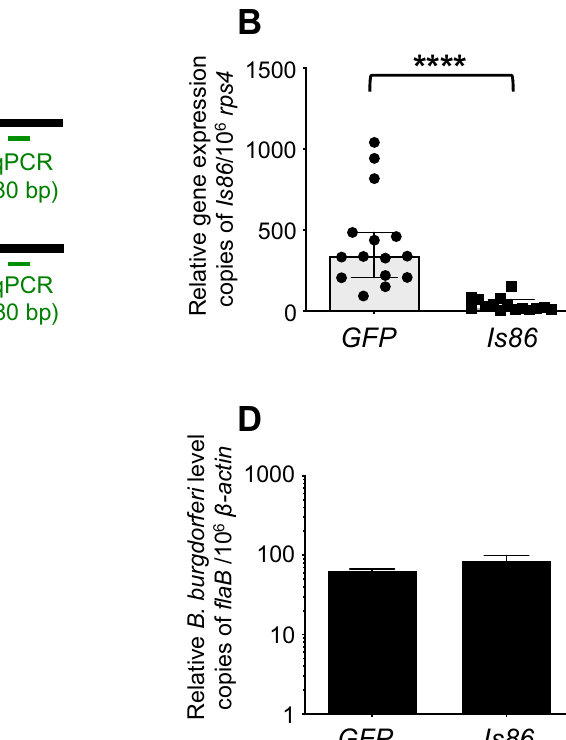
(Fig. 6D). The results indicated that the RNAi-mediated knockdown of Is86 failed to influence spirochete persis- tence in ticks and pathogen transmission to the host. Discussion